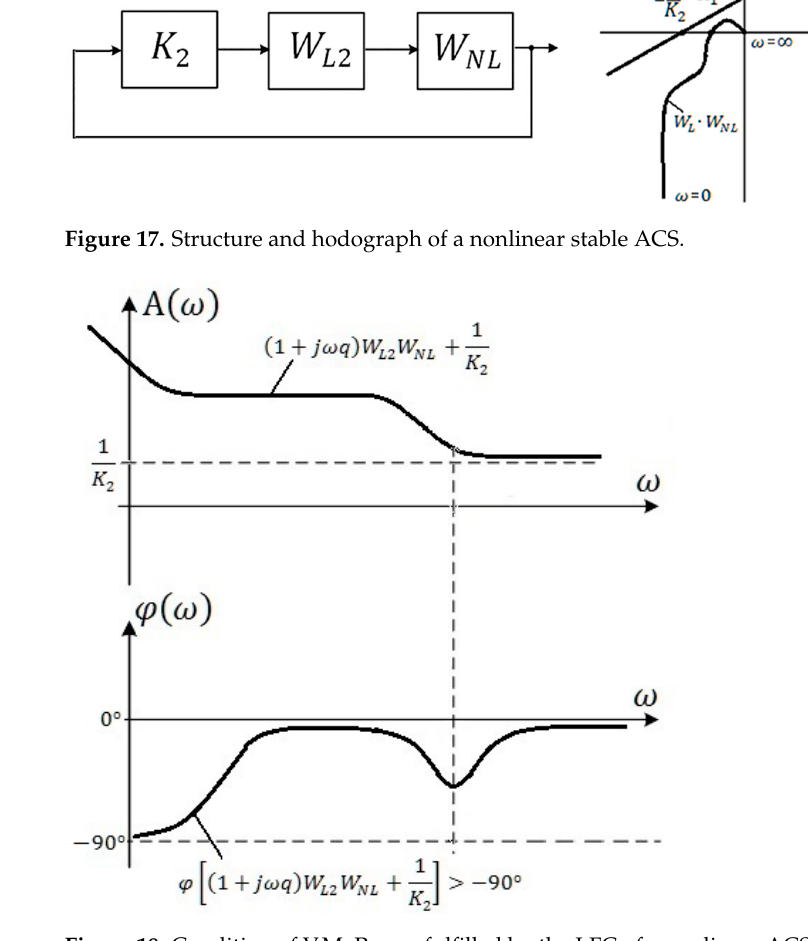
Figure 18. Condition of V.M. Popov fulfilled by the LFC of a nonlinear ACS.